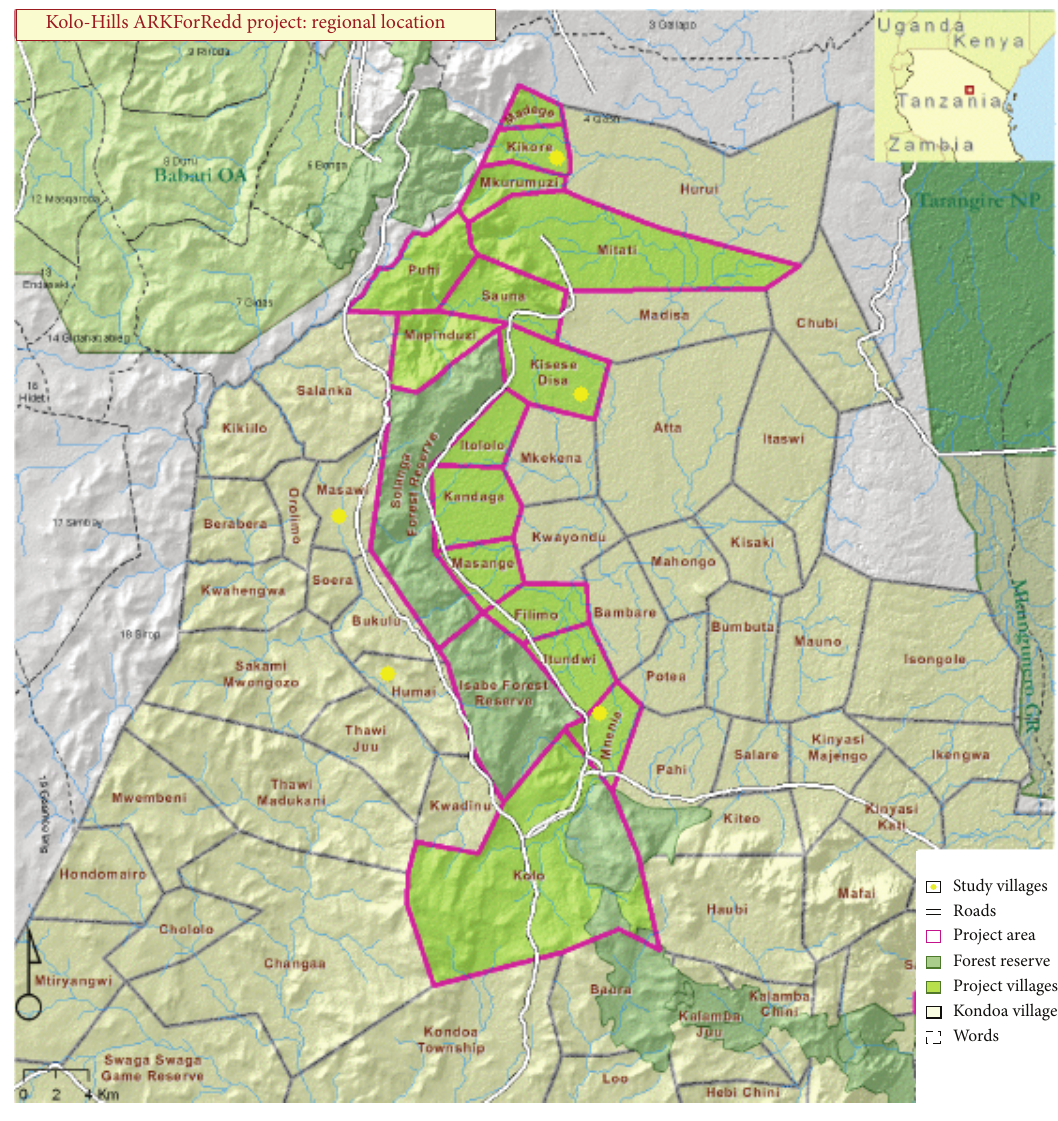
Figure 1: Map of the study area showing ARKFor REDD+ pilot and CCIAM project area and study